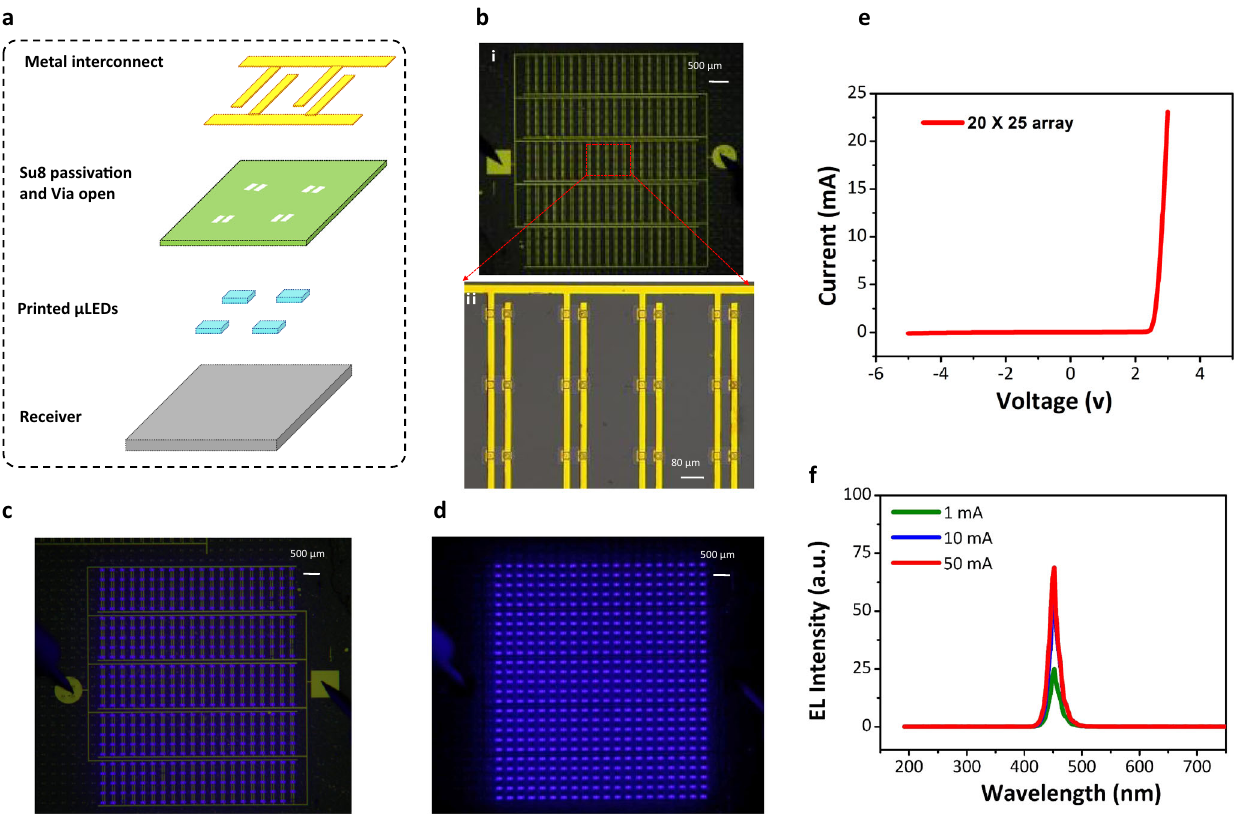
Fig. 7 Interconnection of transfer-printed Micro-LEDs for displays. a Exploded view of the interconnected Micro-LED display device architecture. b Optical image of the resulting 25 × 20 Micro-LED array. c Bright- fi eld image of the full array switched on. d Dark- fi eld image of the full array switched on. e I-V of the interconnected Micro-LED display device. f Current-dependent EL spectra of the interconnected Micro- LED array